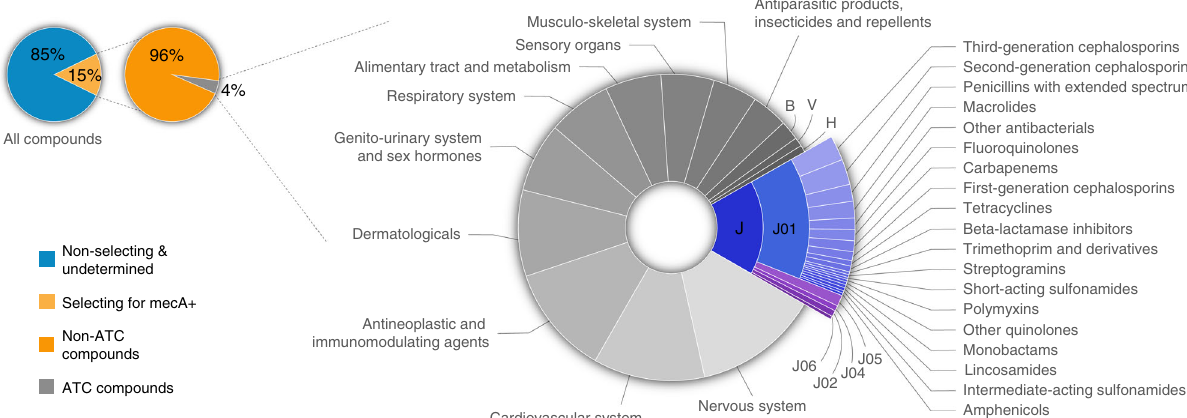
Fig. 2 In the presence of subinhibitory concentration of cefoxitin, diverse antibiotic classes and non-antibacterial therapeutic drugs select in favour of mecA . Of all tested compounds, 15% (8421/58,038 compounds analysed in Single-Dose and Dose-Response assays and compounds analysed only in Dose-Response assay, Methods) showed selection activity in favour of mecA , of which 4% (332) were compounds of known anatomical therapeutic chemical (ATC) drug groups as indicated (legend for abbreviations: B blood and blood forming organs; V various; H systemic hormonal preparations, excluding sex hormones and insulins; J antiinfectives for systemic use; J01 antibacterials for systemic use; J02 antimycotics for systemic use; J04 antimycobacterials; J05 antivirals for systemic use; J06 immune sera and immunoglobulins). Drugs belonging to more than one ATC drug group were counted once for each group. Source data are provided as a Source Data fi le.